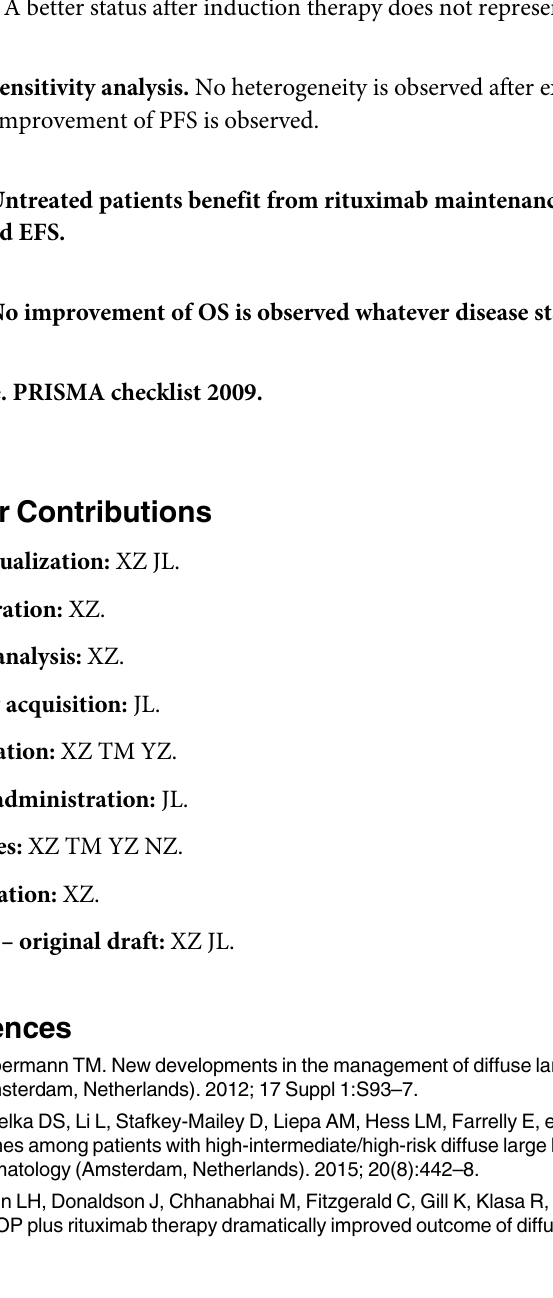
S1 Fig. Subgroup analysis according to patients’ states (CR or CRu/PR) after induction therapy. A better status after induction therapy does not represent a better EFS. S2 Fig. Sensitivity analysis. No heterogeneity is observed after excluding Gisselbrecht’s study. And an improvement of PFS is observed. S3 Fig. Untreated patients benefit from rituximab maintenance with an apparently improved EFS. S4 Fig. No improvement of OS is observed whatever disease status the patients are in. S1 Table. PRISMA checklist